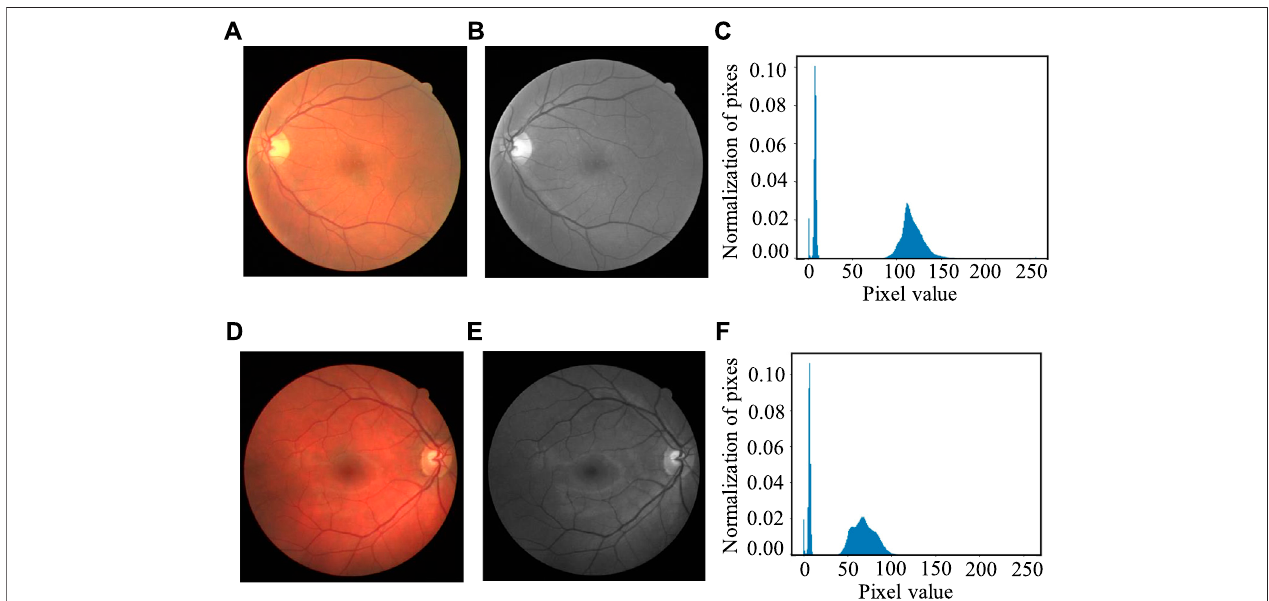
FIGURE 7 | Two cases of gray histogram: (A, D) Original color image, (B, E) Gray image of the green channel and (C, F) Gray histogram of (B,